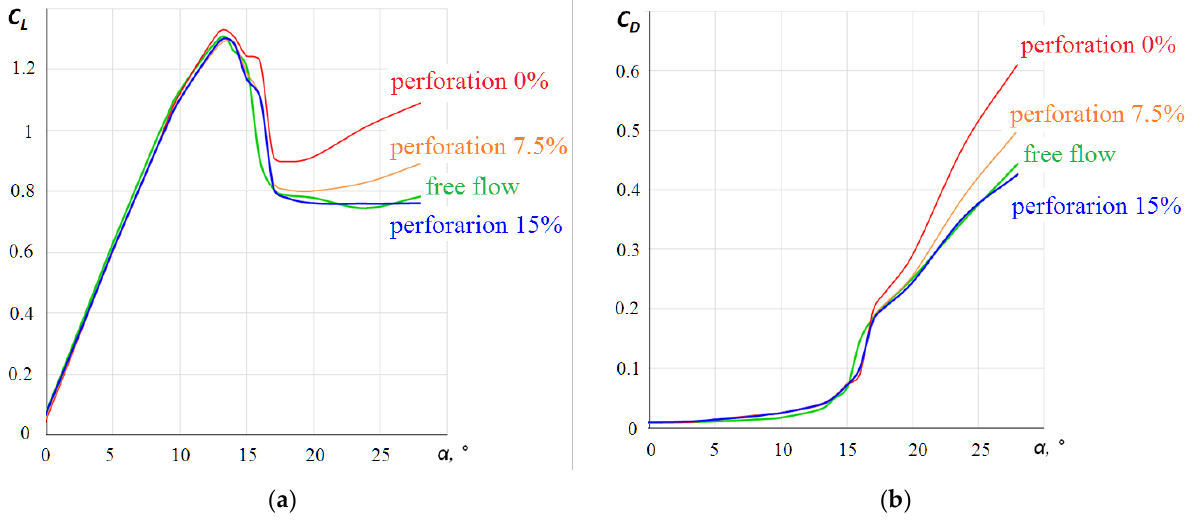
Figure 7. Calculated dependencies of the lift ( a ) and drag force coefficients ( b ) of the SC1095 airfoil on the pitch angles for various perforation percentage values and for free flow conditions.